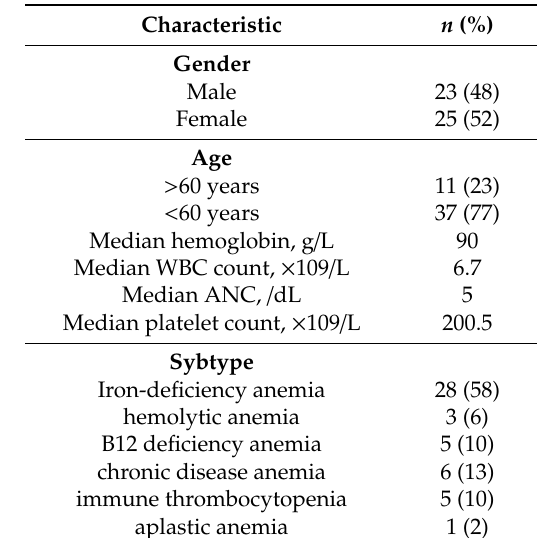
Table 1. Clinical data of non-cancerous blood diseases (NTP) ( n =